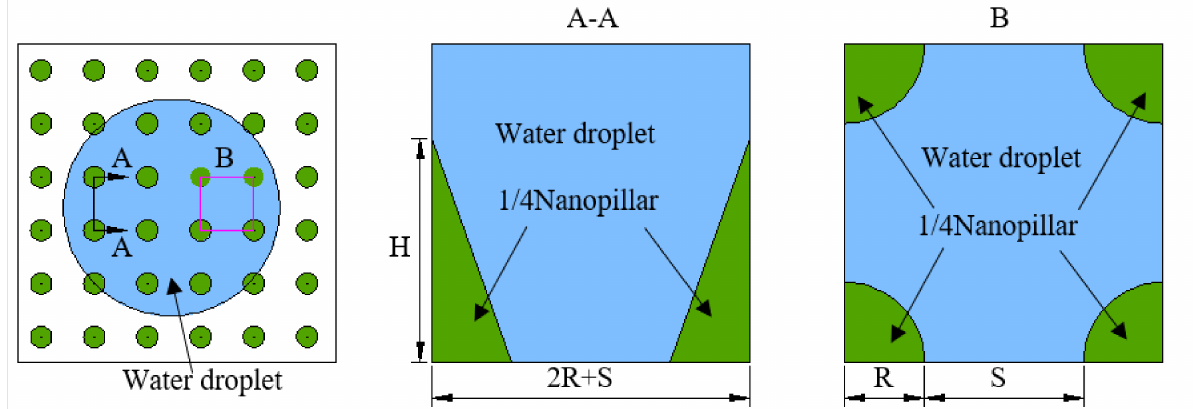
Figure 6. Idealized geometric model of the banana leaf’s adaxial